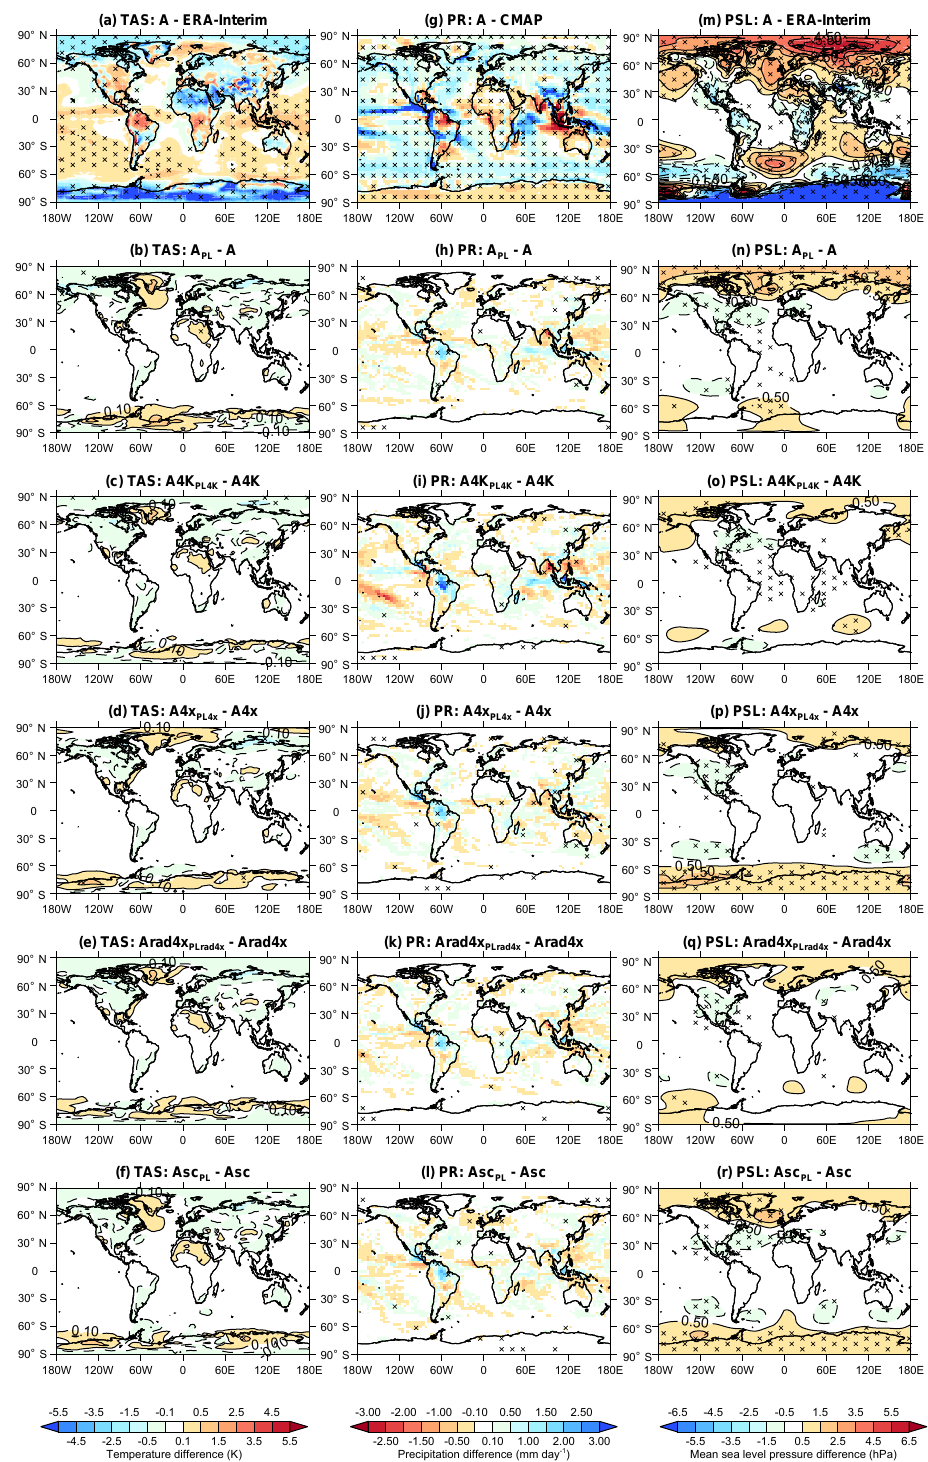
Figure 1. Differences in surface air temperature (TAS, K) for (a) A minus ERAI, (b) A PL minus A, (c) A4K PL4K minus A4K, (d) A4x PL4x minus A4x, (e) Arad4x PLrad4x minus Arad4x, and (f) Asc PLsc minus Asc. Equivalent differences between observations/simulations are given in panels (g–l) and (m–r) for precipitation (PR, mmday − 1 , CMAP data used in panel g ) and mean sea level pressure (PSL, hPa, ERAI data used in panel m ), respectively. The points labelled with an “x” indicate the differences are statistically significant using Student’s t test ( p ≤ 0 .